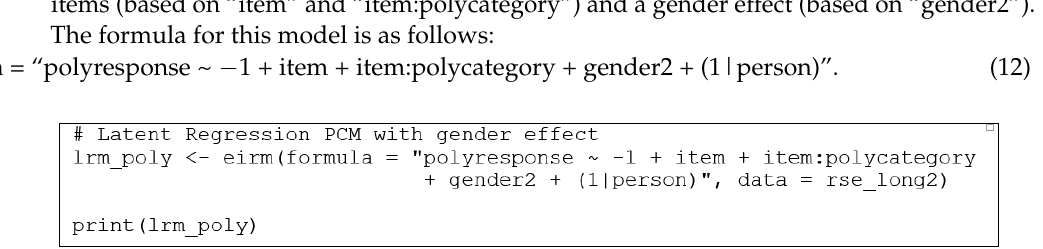
Figure 16. Estimate the latent regression PCM and print the model output.